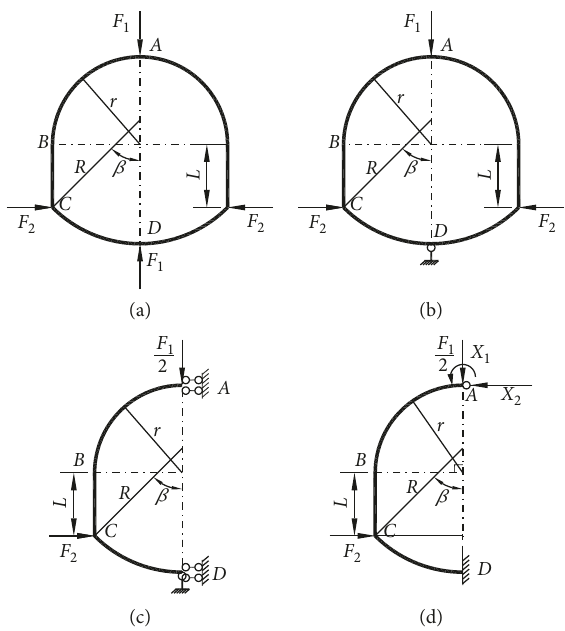
Figure 5: Structural mechanics analysis on the set: (a) set in the static equilibrium state; (b) set with one hinge on the bottom arch; (c) stress state of the half set; (d) final stress state of the half